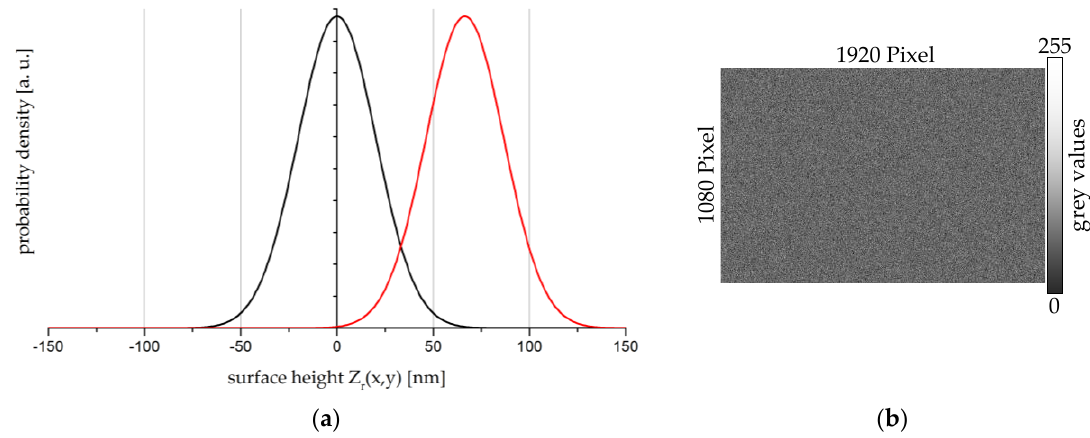
Z (x,y) with standard r R on the incident q,r